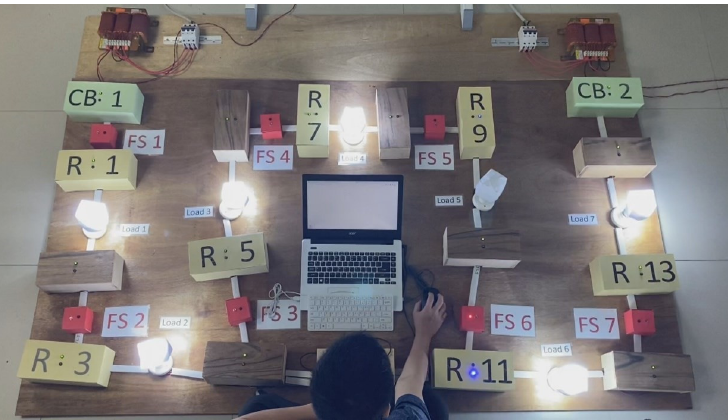
Figure 17. Hardware prototype after restoration steps.